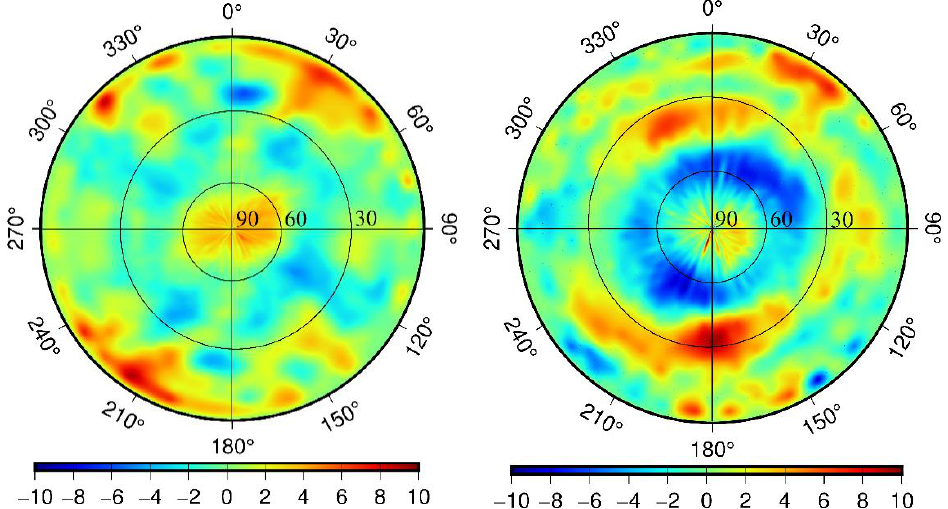
Figure 10. Azimuth-elevation maps of the 5° × 5° PCV (mm) for the ionosphere-free linear combination of the GRCC ( left ) and CS01 ( right ).